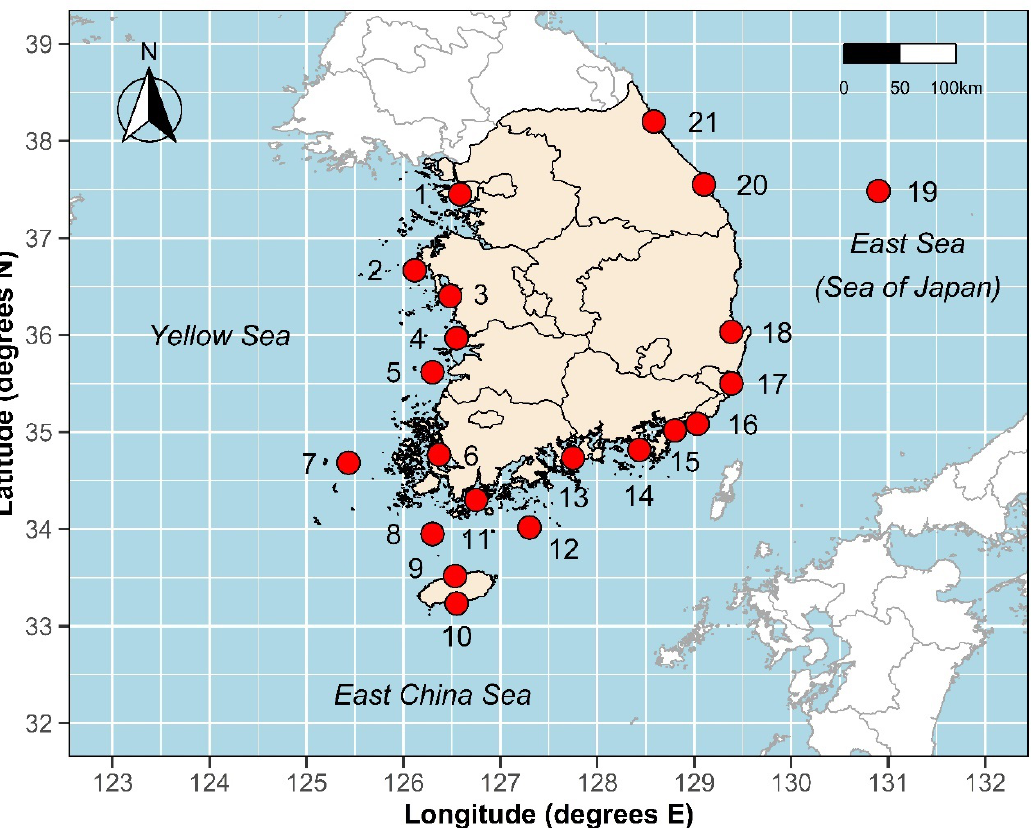
Figure 1. Location of tide gauge records analyzed for this study. Full details of data records are summarized in Table 1.